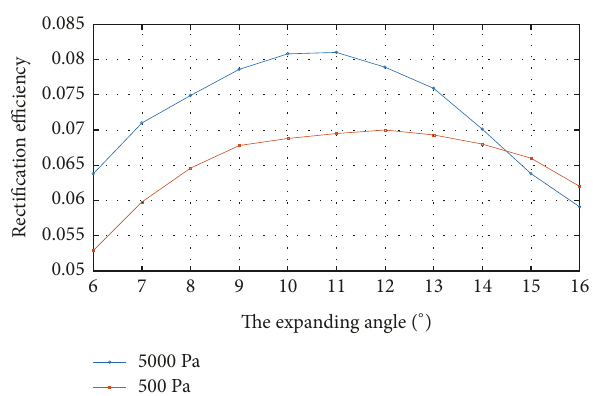
Figure 13: Relationship between the expanding length and the expanding angle.